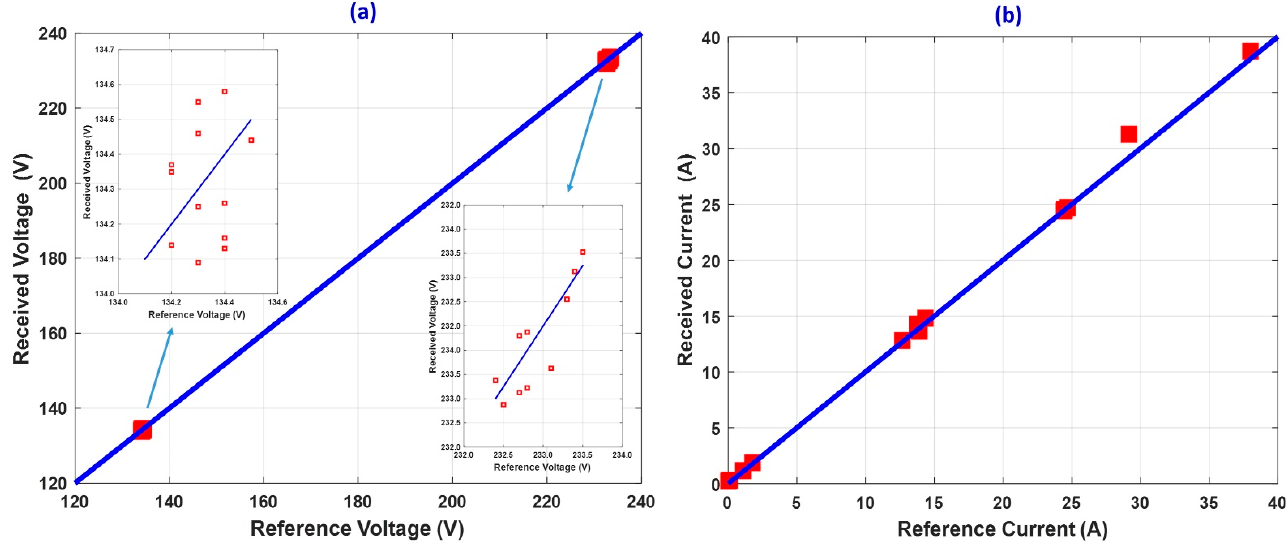
Figure 6. Voltage and current readings received and displayed by IoT dashboards versus those measured by reference instruments. The blue straight lines represent lines of equality. Insets are magnified areas of the voltage plot ( a , b ).